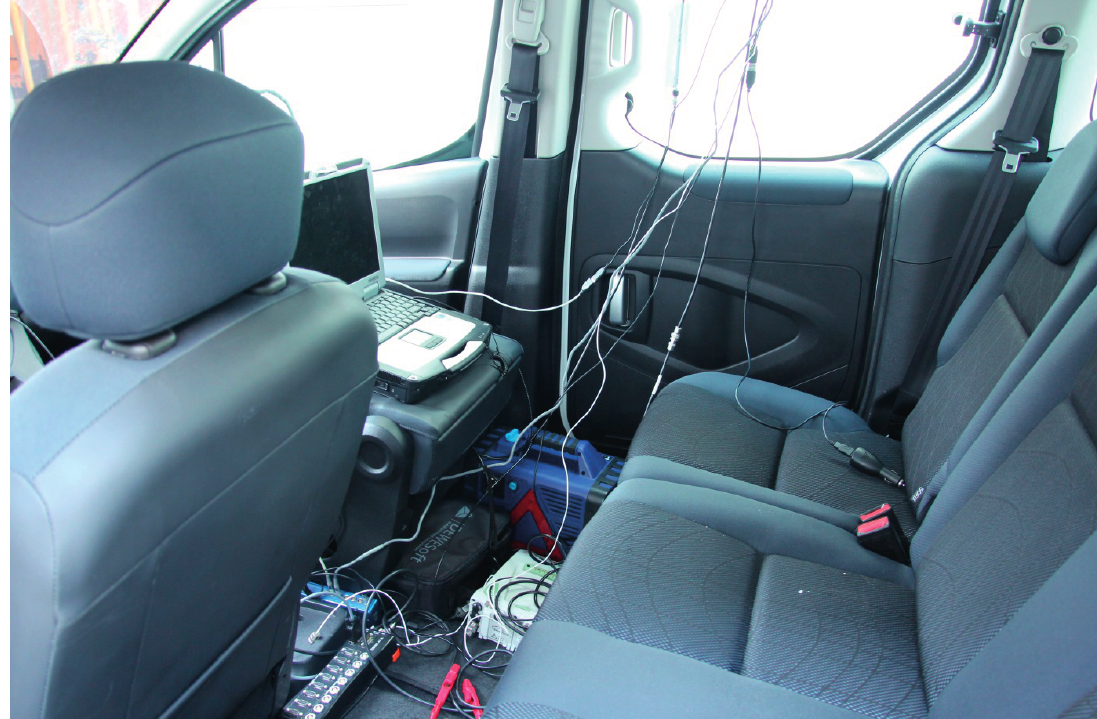
Figure 2. Laptop with the external analog-digital unit in the vehicle synchronously stored data from two GNSS systems and the vehicle